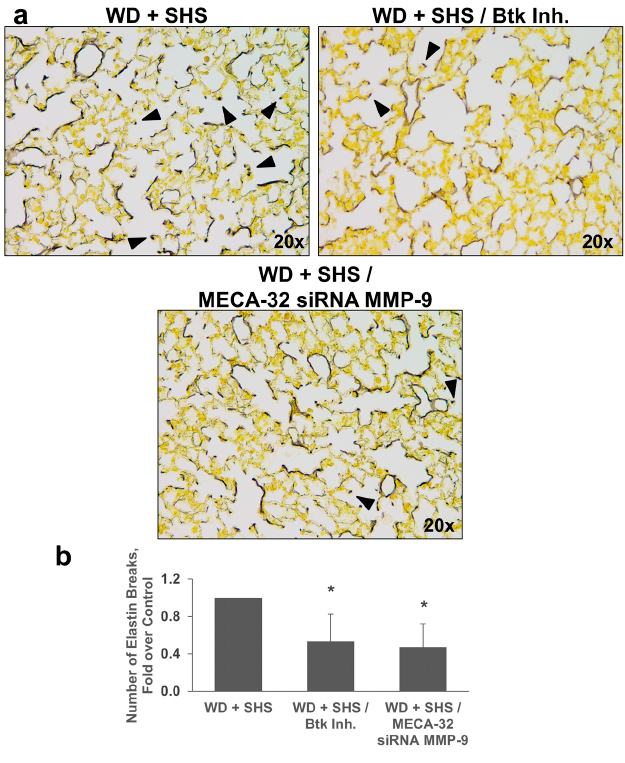
Figure 4. Analysis of alveolar elastin breaks in lungs of ApoE − / − mice fed WD and exposed to SHS only (WD + SHS), with Btk inhibitor treatment (WD + SHS / Btk Inh.), or treated with endothelial cell targeted siRNA for MMP-9 (WD + SHS / MECA-32 siRNA MMP-9). Representative images are shown. Black arrows point out strand breaks in alveolar walls ( a ). Destruction of alveolar walls was assessed by counting numbers of breaks in elastin fibers ( b ). Groups receiving treatment scored significantly lower than the control group ( p < 0.05). Kruskal–Wallis ANOVA on ranks was used to assess statistical significance between groups ( p < 0.001) followed by post hoc testing with Dunn’s multiple comparison test for groups of interest, four to six mice per group were evaluated. * Significant difference